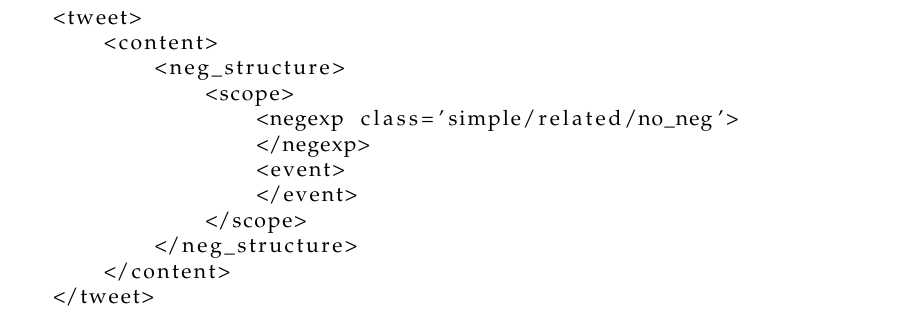
Table 3. General statistics computed from word counts on each tweet.